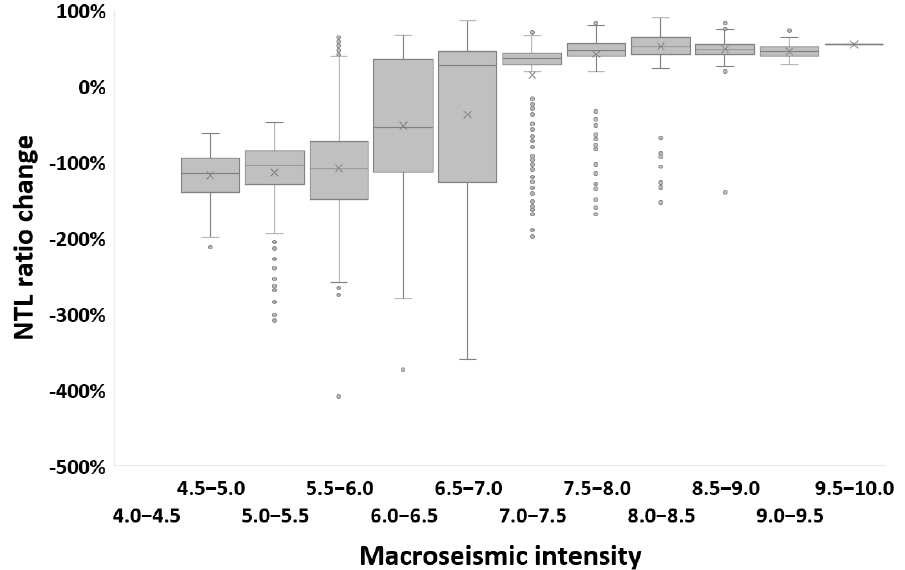
Figure 3. Statistically significant ( p < 0.01) NTL changes between the median of the period before the earthquakes (1 January–5 February, 36 days) and the median of the period after the earthquakes (7–20 February, 14 days), expressed as the ratio between the difference and pre-earthquake NTL values. NTL ratio changes > 0% indicate a decrease in NTL, whereas negative ratios indicate an increase in NTL. Boxplots of NTL ratio changes for VIIRS lit grid cells in the study area are shown as a function of MMI values based on the shakemap of the 7.8 magnitude earthquake.